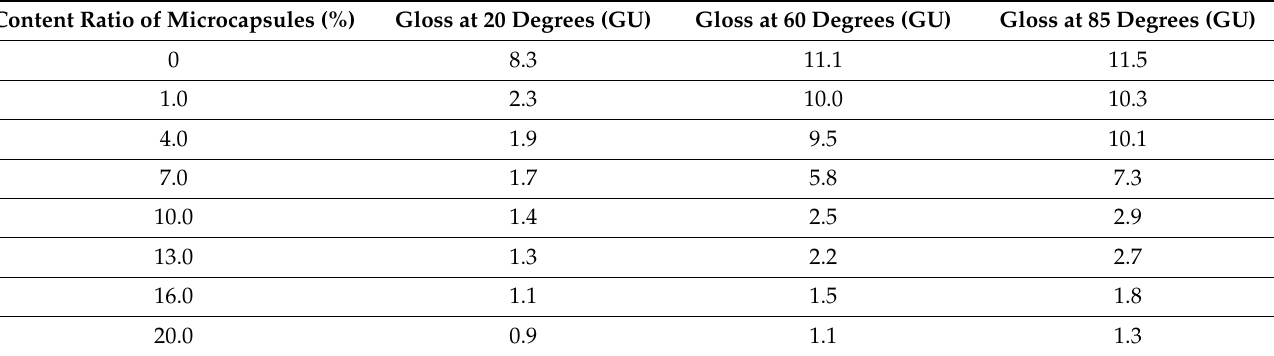
Table 2. Gloss performance table with core ratio of 0.40.